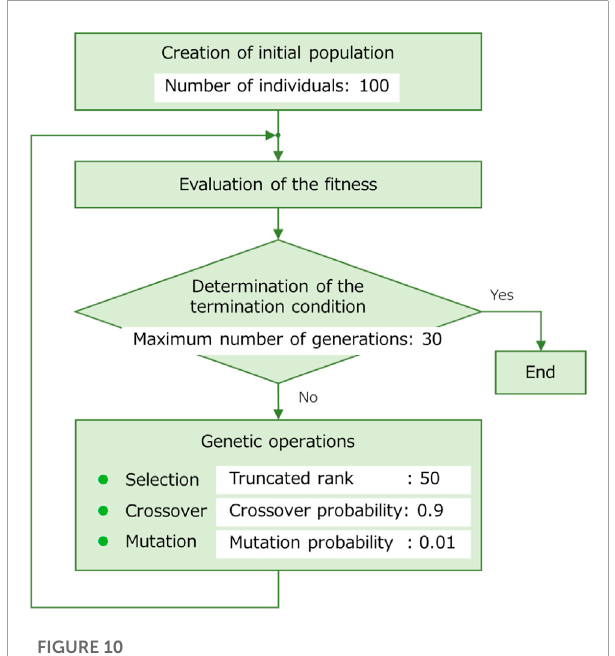
FIGURE 10 The flow and parameters of the